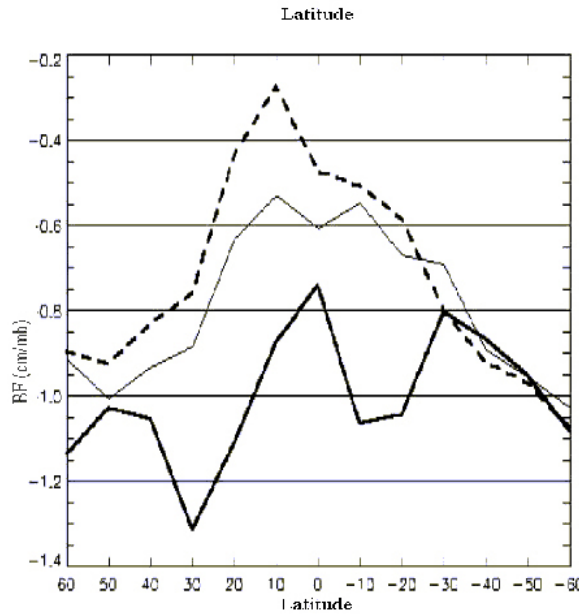
Fig. 8. Meridional distribution of BF estimated using EOFD tech- nique at different time samplings: 35 days (gross solid line), 11 days (thin solid line) and 4 days (dashed